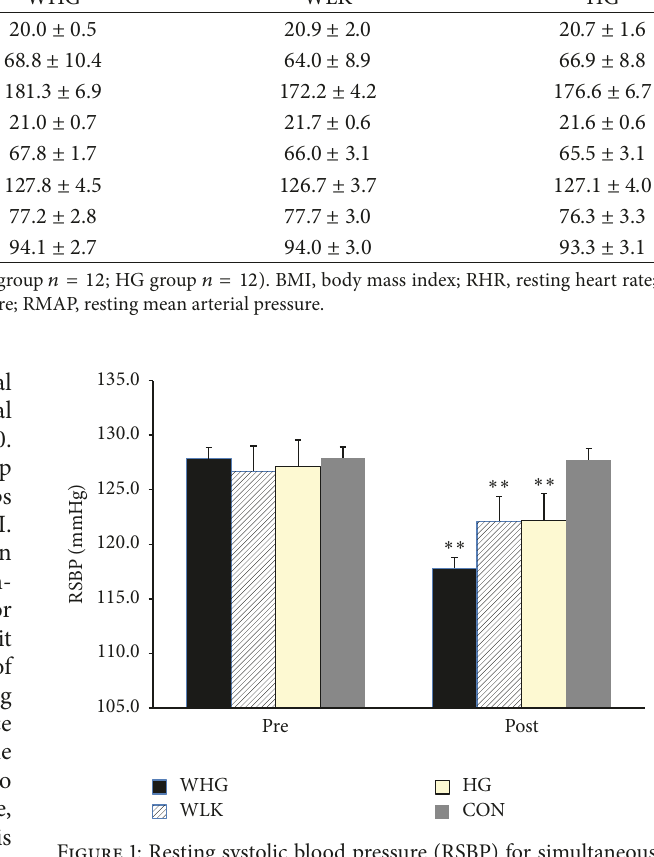
Figure 1: Resting systolic blood pressure (RSBP) for simultaneous walkingandhandgrip(WHG),walking(WLK),handgrip(HG),and control (CON) groups before and after training. ∗∗ 𝑃 value <